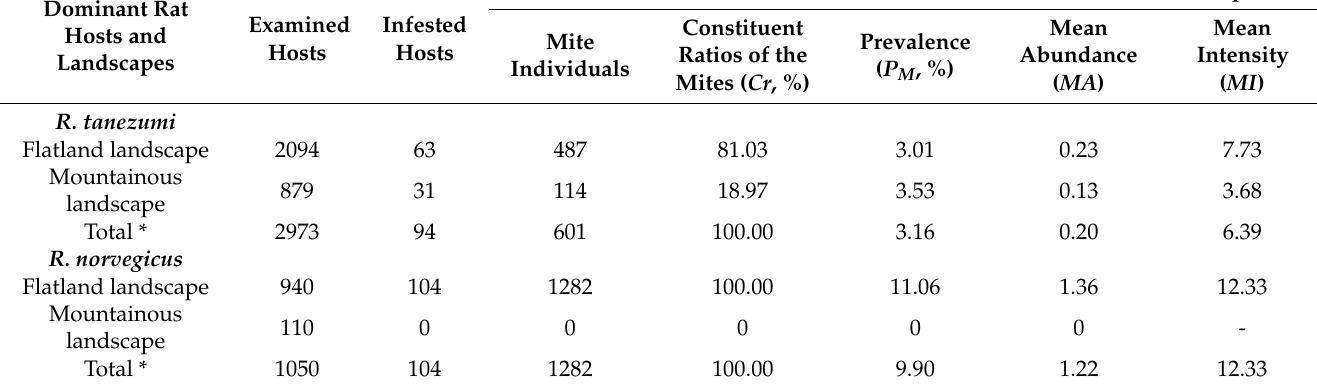
Table 7. Infestations of R. tanezumi and R. norvegicus rats with O. bacoti mites in different landscapes of Yunnan Province, Southwest China (1990–2015).